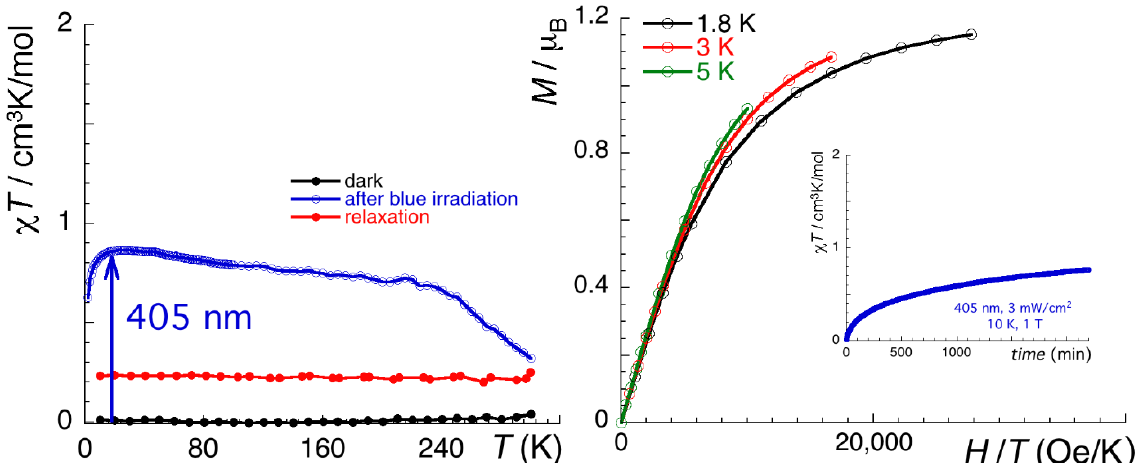
Figure 4. ( Left ) χ T = f( T ) plots of 2 measured at 1 T and 0.4 K/min: in the dark before irradiation (dark points), after 405 nm irradiation (open blue points) and after reconditioning at 300 K (red points). ( Right ) Reduced magnetizations at different temperatures (1.8 K, 3 K and 5 K) in the photo-excited state of 2 (open points). (Insert: Time dependence of the χ T for compound 2 measured at 1 T and 10 K, with continuous irradiation of wavelength of 405 nm (3 mW/cm 2 )).